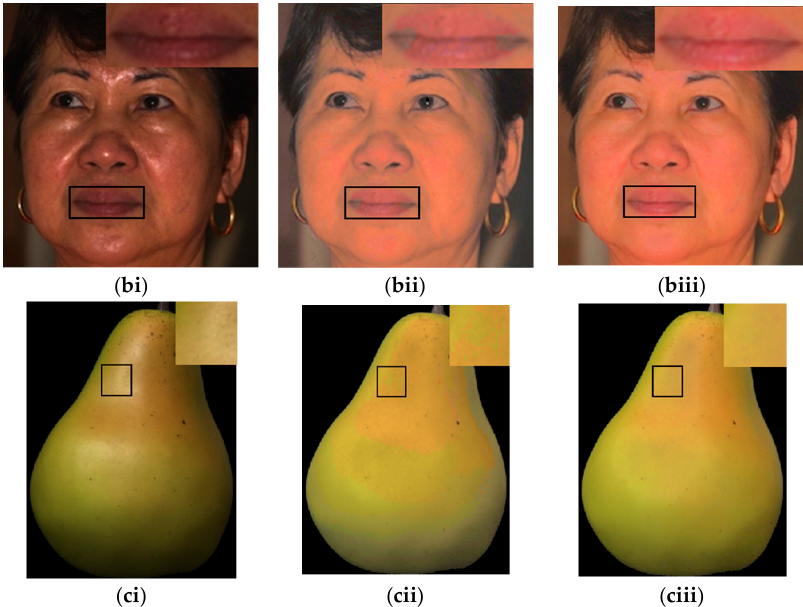
Figure 9. Comparison of Shen [22] and our method locally: ( ai – ci ) input LDR images ( Hen , Face , and Green Pear ); ( aii – cii ) HDR images using Shen’s [22] HF images; and ( aiii – ciii ) HDR images by our proposed method.